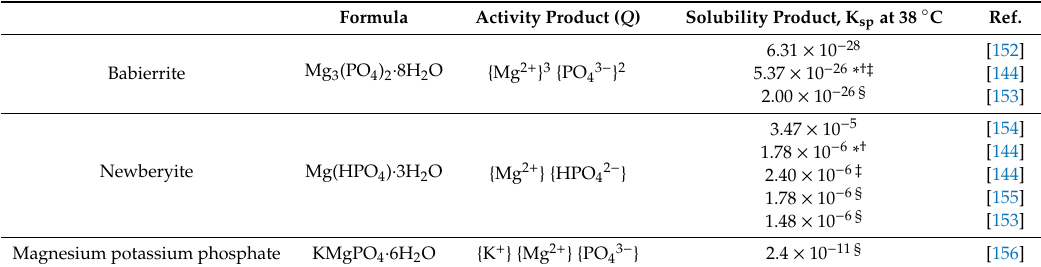
Table 5. The precipitation of insoluble magnesium phosphates. The activity products ( Q ) and the solubility products K sp (at 38 ◦ C) are obtained from the